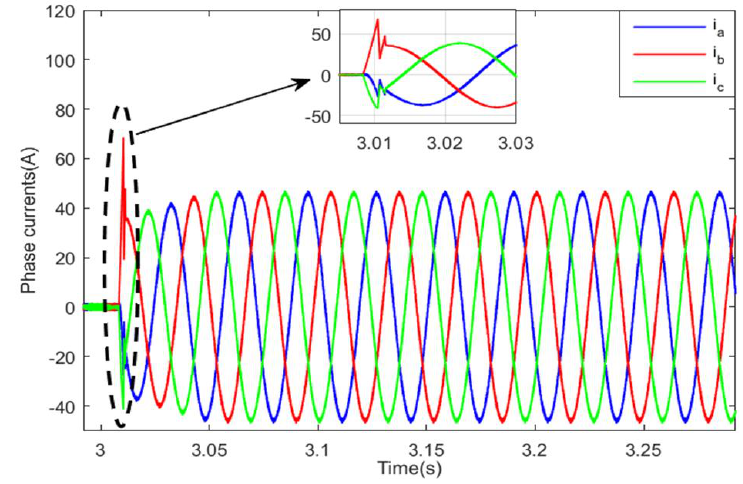
Figure 24. Resulted PMSM currents with abrupt switching.